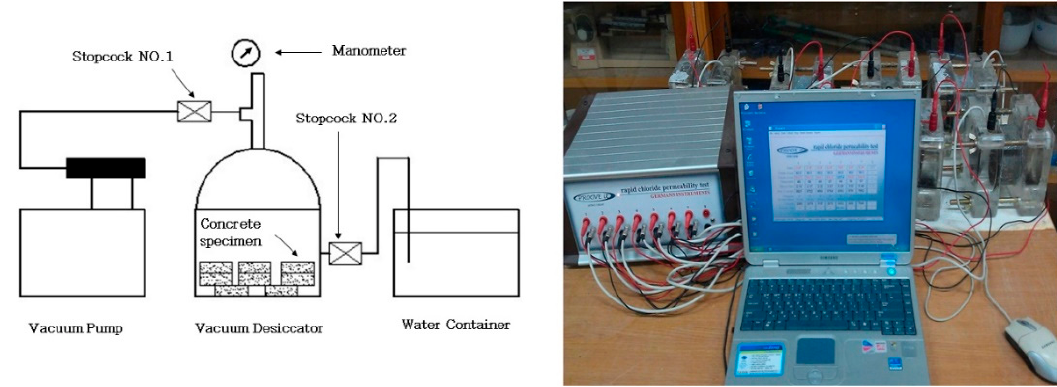
Figure 3. Chloride ion penetration test set-up.